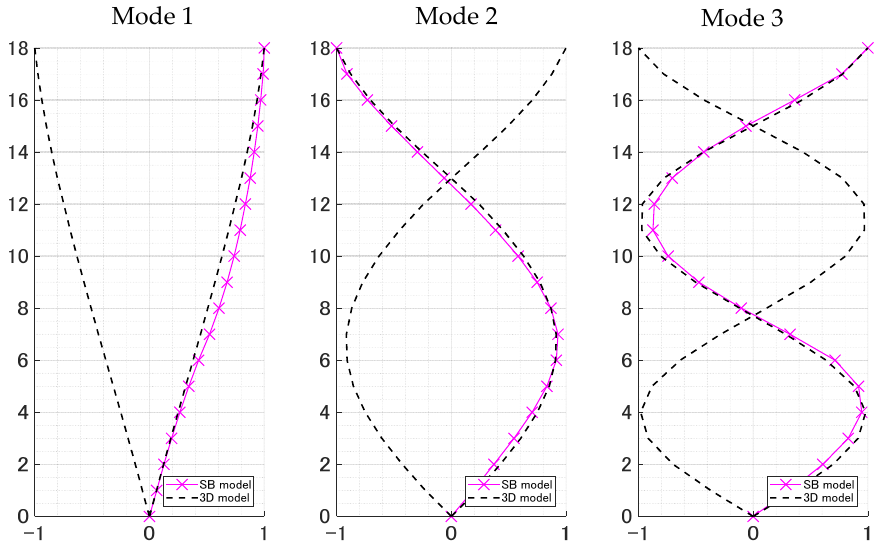
Figure 5. Comparison of 1st to 3rd mode shapes between the 3D and simplified planar model ( y -direction).